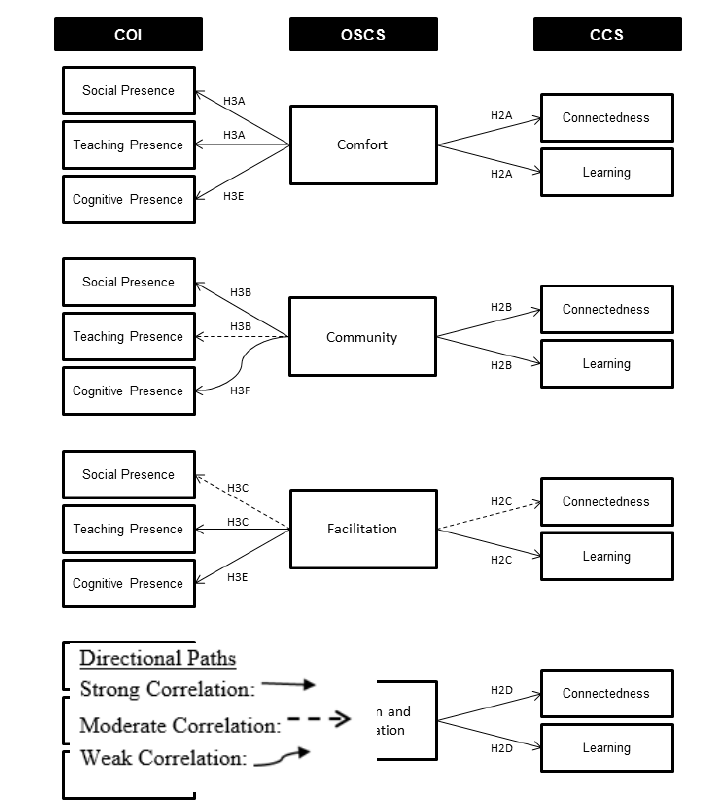
Figure 1 . Hypothesized model for OSCS nomological